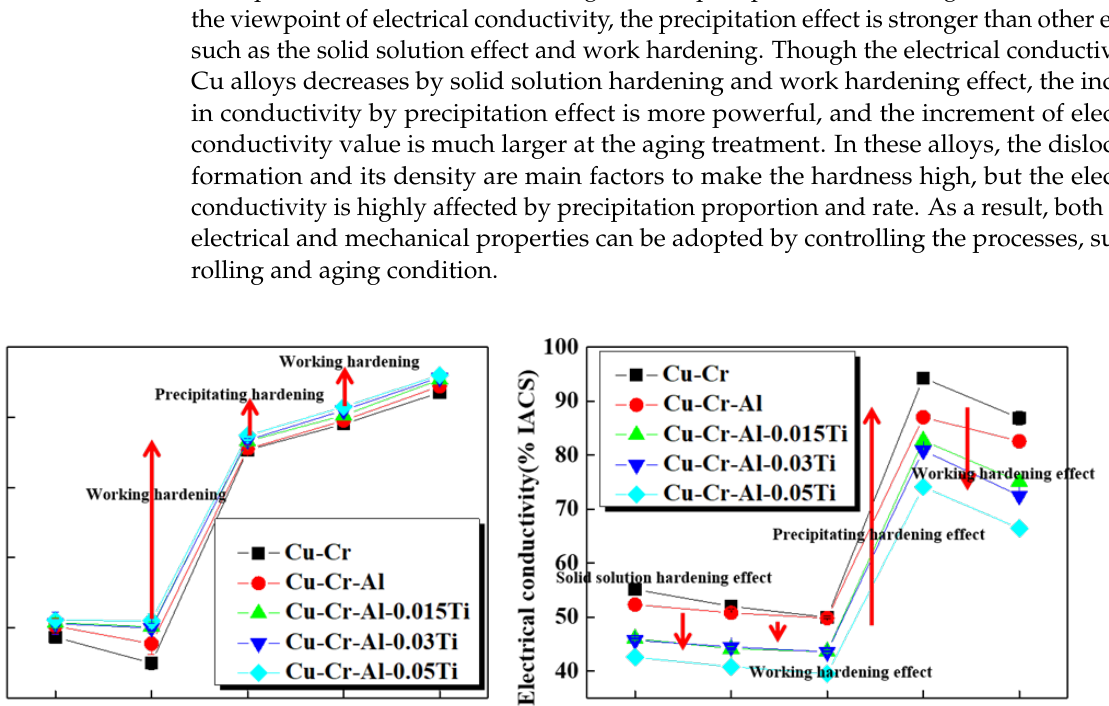
Figure 10. Variation of resistance to softening characteristics of Cu-Cr alloys.